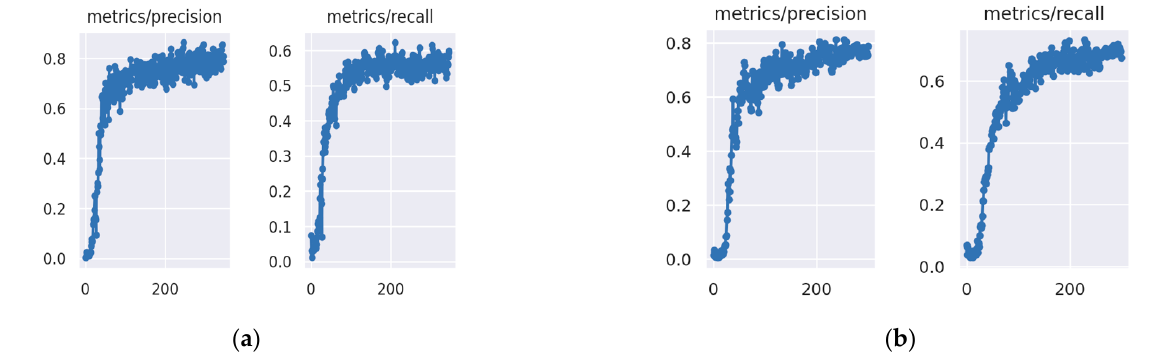
Figure 12. ( a ) Precision and recall plot of FPN + PANet; ( b ) precision and recall plot of BiFPN.